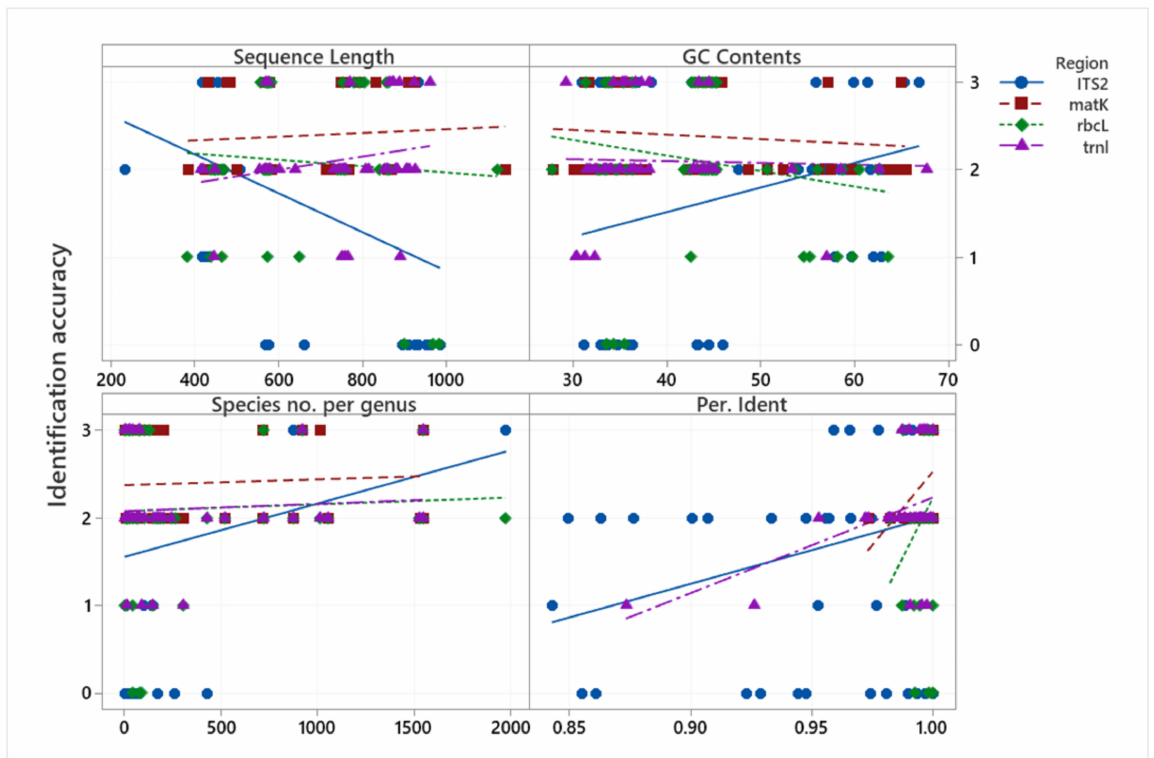
Figure 3. Scatterplot of identification accuracy vs. sequence length (bp), GC Content (%), species number per genus, and percentage of identity. Scale 0–3 represents the identification accuracy (0 = incorrect, 1 = correct at the family level, 2 = correct at the genus level, 3 = correct at the species